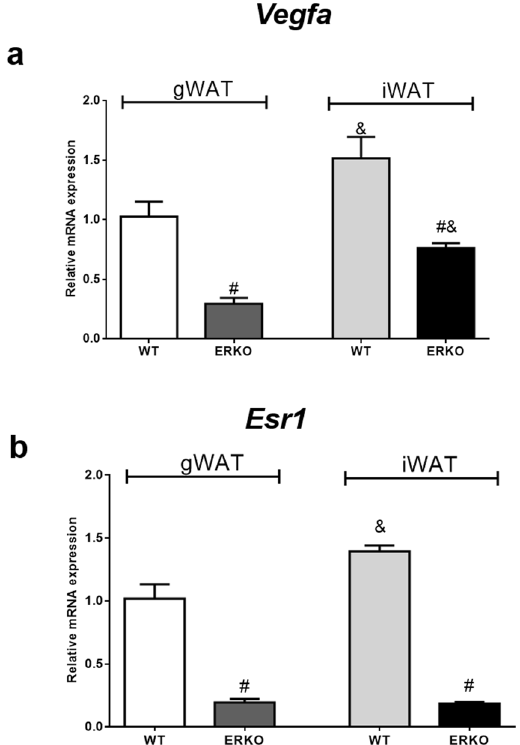
Figure 7. Vegfa ( a ) and Esr1 ( b ) mRNA expression in gonadal (gWAT) and in inguinal (iWAT) adipose tissues from WT and ERKO female mice. Data on the graphs are means ± SEM of 4–7 samples, # p < 0.05 vs WT; & p < 0.05 vs gWAT